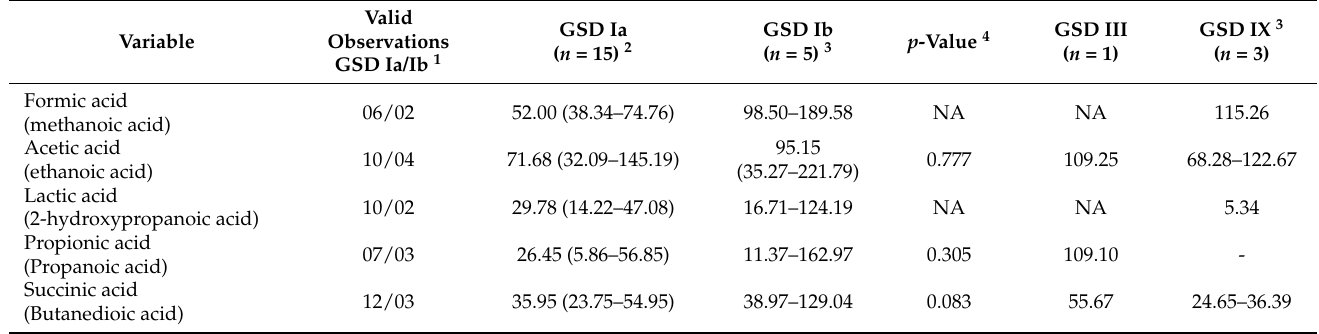
Table 2. Description of clinical parameters and measured metabolites among GSD types.